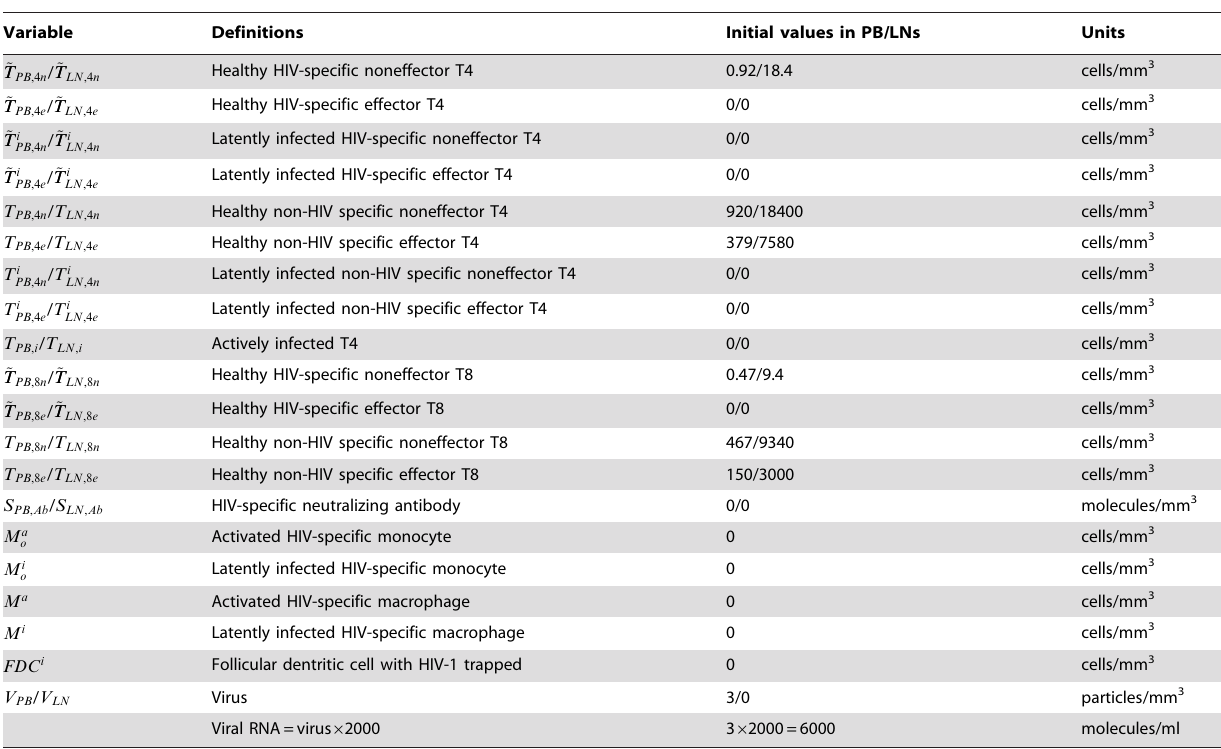
Table 6. Variables of the model and their initial